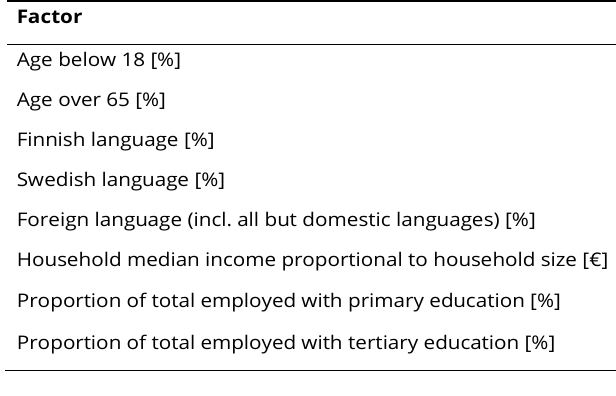
Table 1. Analyzed socio-economic and demographic factors based on the YKR